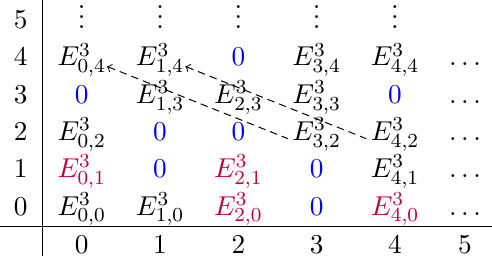
Table 4 . Third page E 3 of the same spectral sequence and all possible d 3 differentials. The blue differentials have (co-)killed the page elements they were acting on, while the purple ones let them partially survive. The black elements, on which no differential acted, carried over intact to the next ∼ = E 2 page, i.e. E 3 p,q p,q